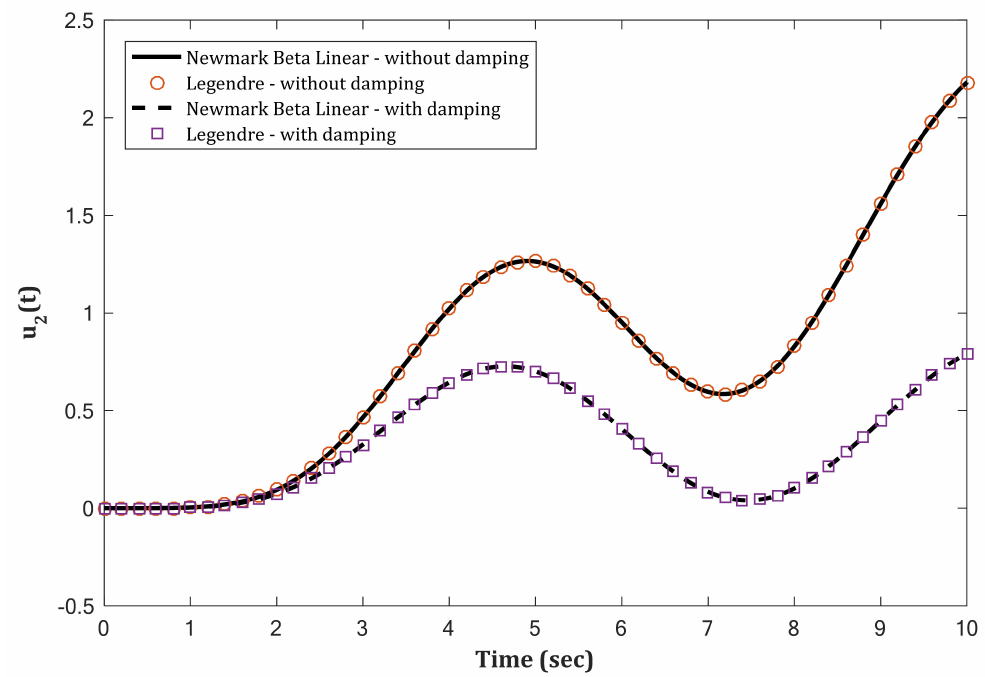
Figure 11. Forced vibration analysis of a 3DOF system. Comparison of u 2 ( t ) as a function of time, as obtained using the LGM method or the linear Newmark- β